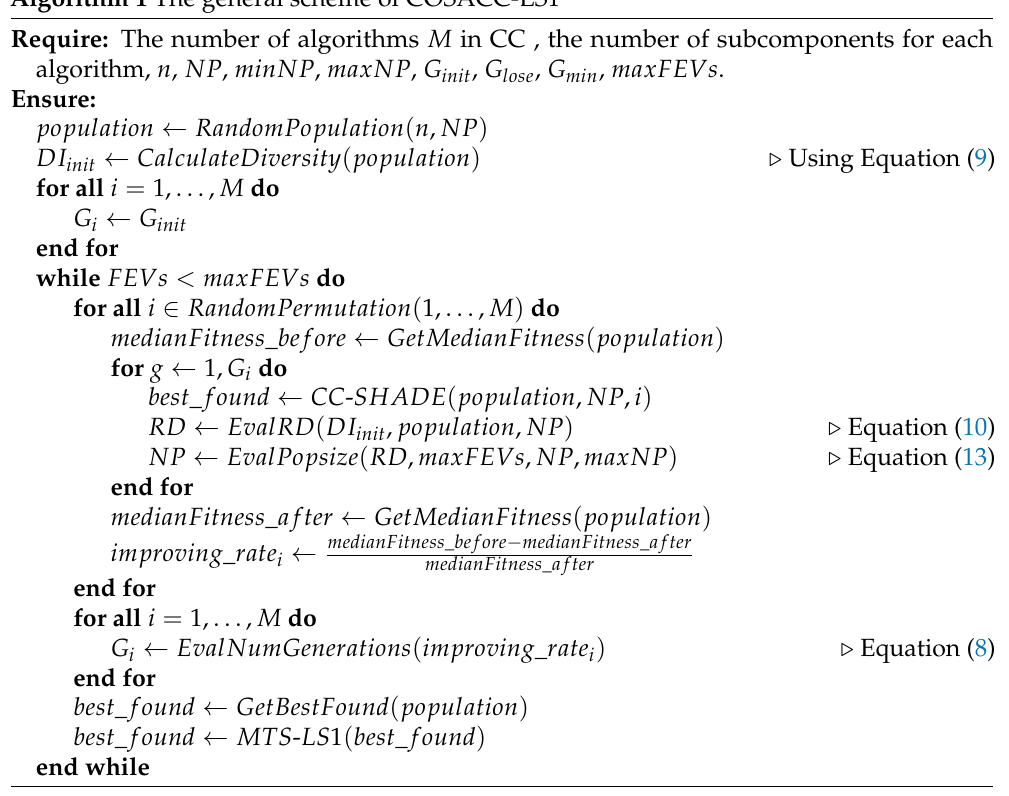
Algorithm 1 The general scheme of